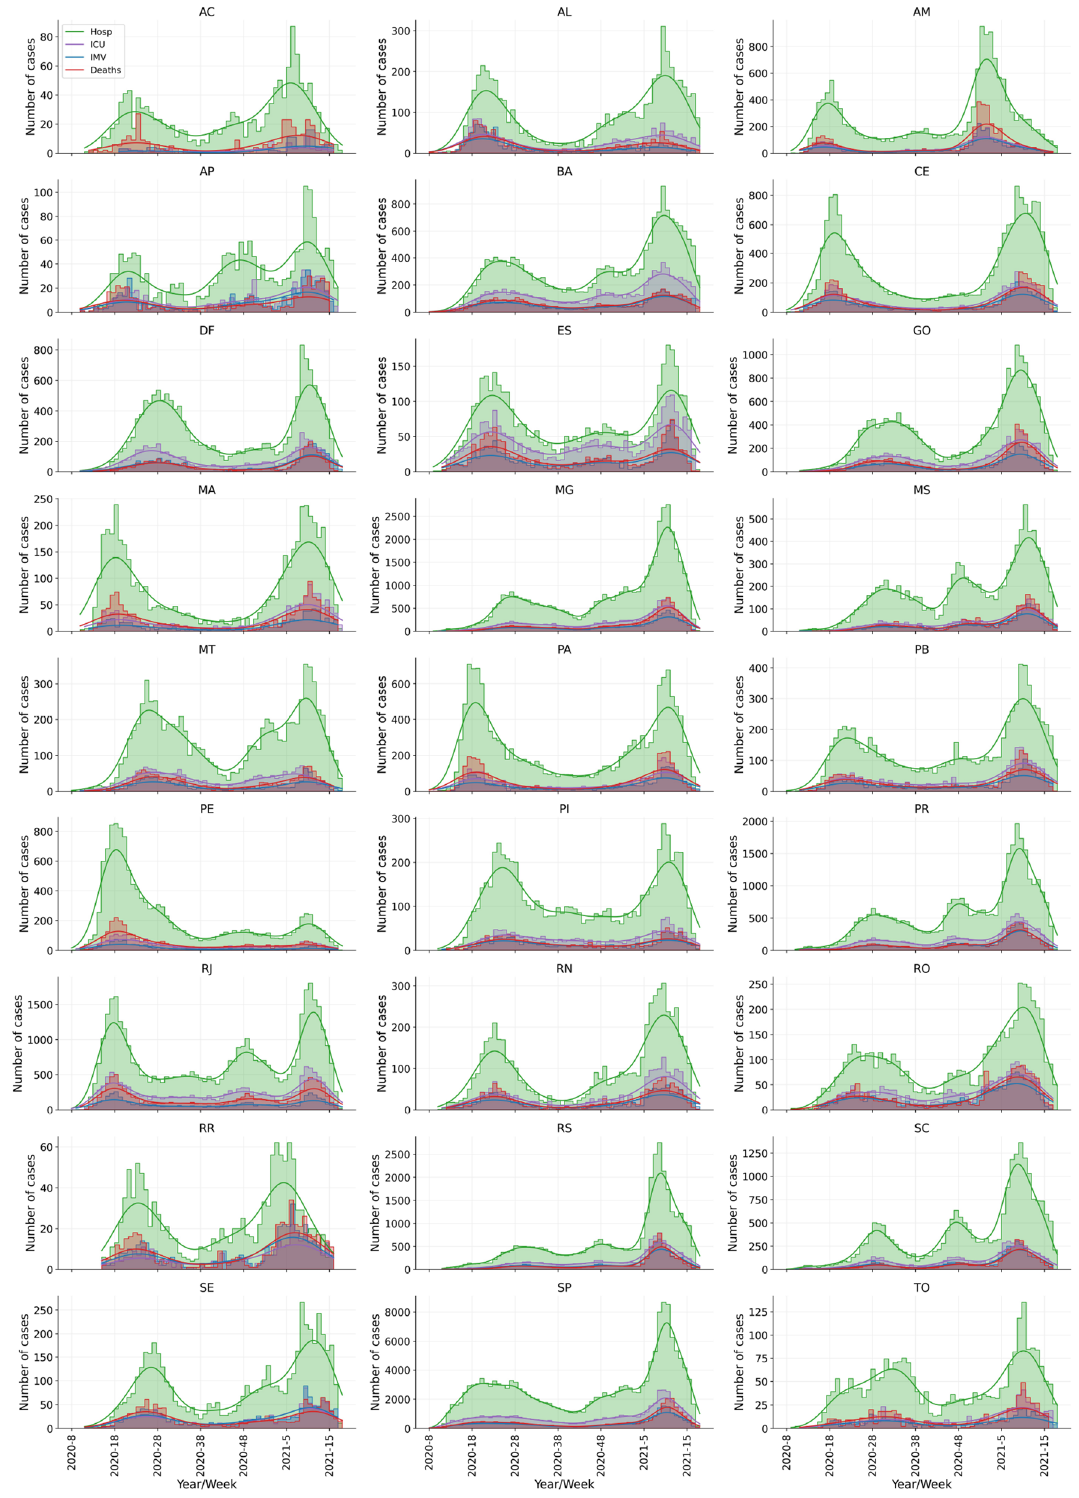
Figure 2. Outbreaks desynchronization (atypical waves) among the federative units in Brazil. Time series of confirmed cases for COVID-19 hospitalizations, ICU admission, IMV requirement and in-hospital deaths of patients aged 20–59 years according to the Brazilian federative units. The horizontal axis (x-axis) refers to the epidemiological weeks according to the onset of symptoms. Timeline was divided into six periods of 10 weeks each, from epidemiological week 2020-8 to